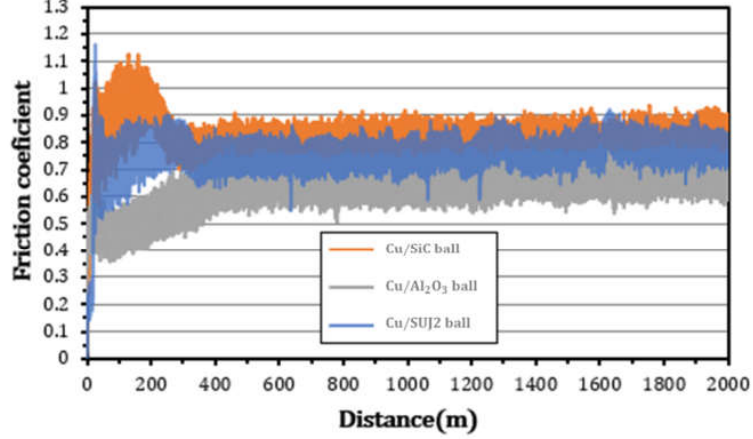
Figure 3. Evolution of friction coefficients of copper block sliding against SiC, Al 2 O 3 , and SUJ2 counterbodies at 10 N.